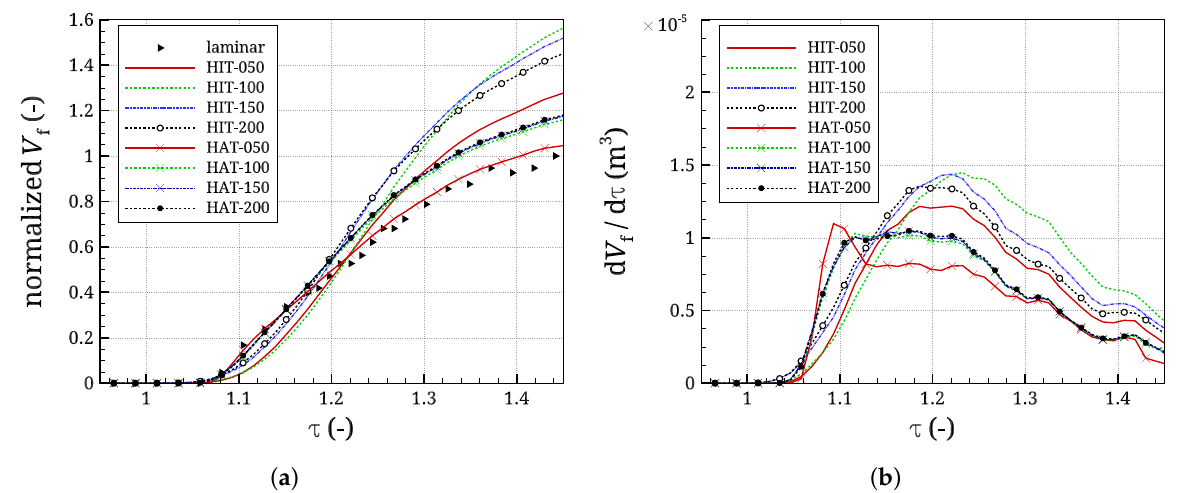
Figure 10. Time evolution of: ( a ) normalized flame volume; ( b ) variation of the flame volume. Figure 11 shows the contours of the mixture fraction ξ and isolines of the selected values of the heat release in the central ‘y–x’ cross-section plane. The subfigures on the left half of Figure 11 correspond to the HIT conditions and on the right half to the HAT regimes. The presented results correspond to two time moments: (i) τ = 1.1 (upper row), when for the HAT cases dV f / d τ reaches the constant level; (ii) τ = 1.23 (bottom row), when for the HIT cases dV f / d τ are maximal. It can be seen that in the HIT conditions the distribution of cases HIT-050 and HIT-100. The heat release isolines are locally torn and the flame